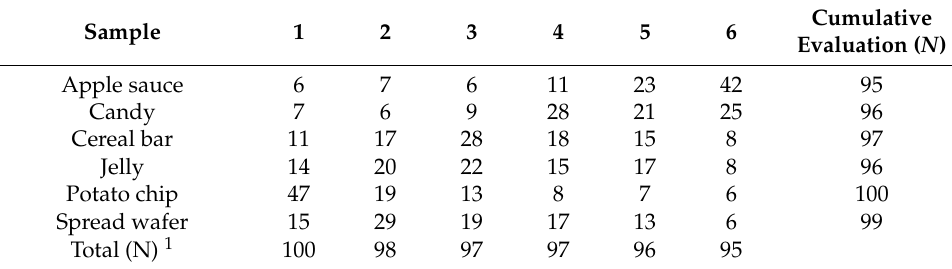
Table 8. Evaluated order frequency for each sample in the ‘No control’